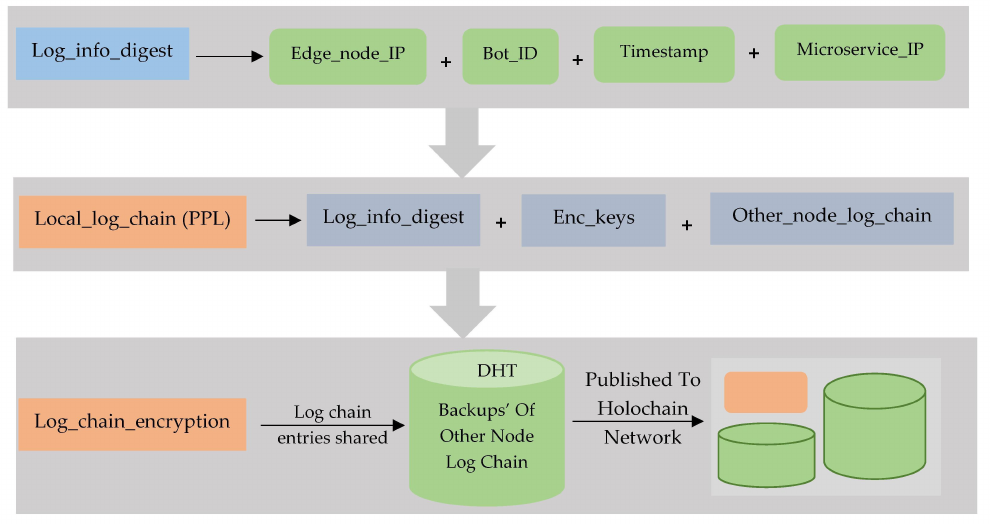
Figure 12. Preserving proof via log